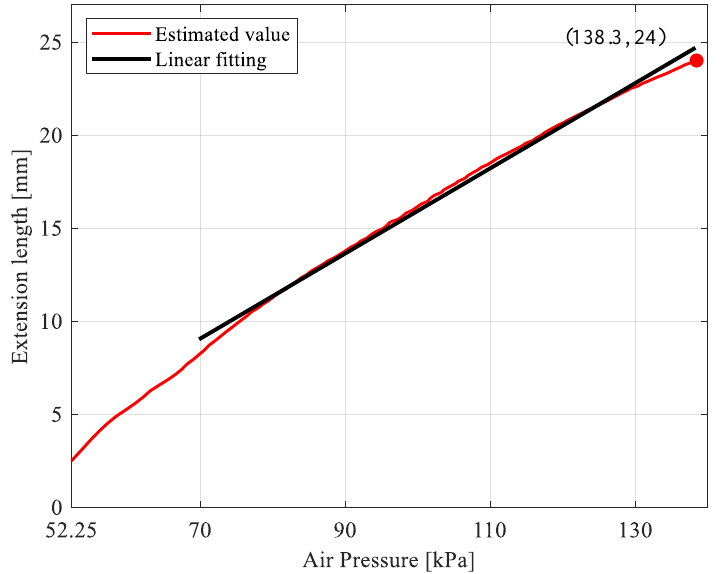
Figure 7. Relationship between the pressure and the extension length of the soft actuator.